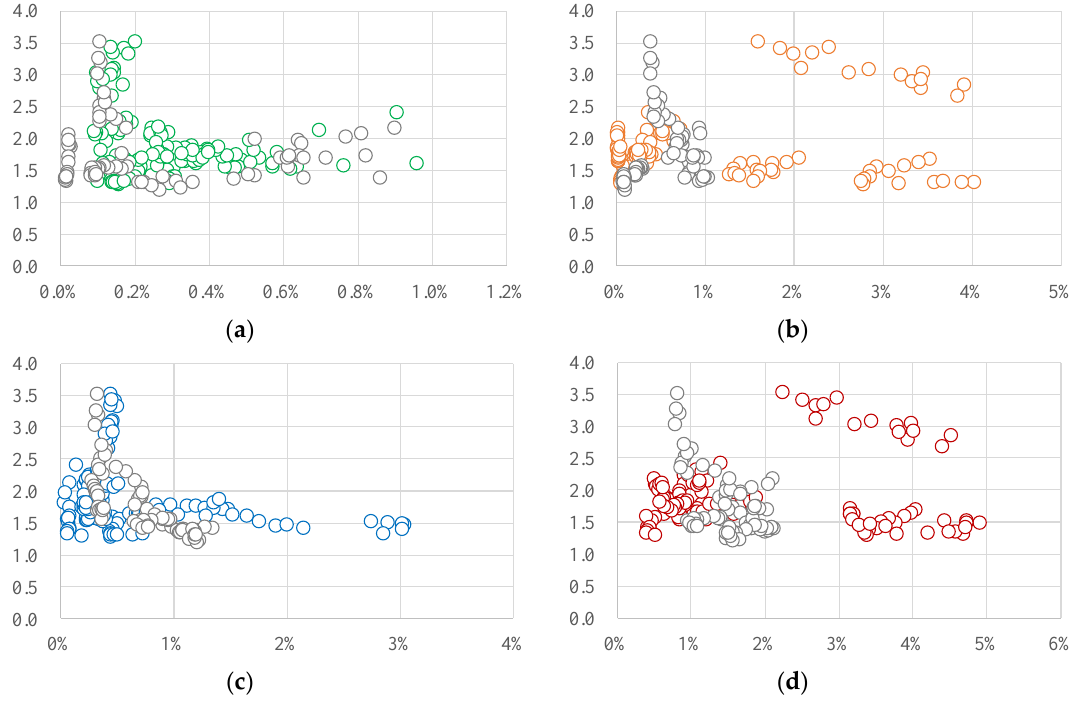
Figure 5. The scatter plot of material productivity (MP) and ICT capital share. ( a ). IT capital share; ( b ). CT capital share; ( c ). Software capital share; ( d ). Share of total ICT capital. Note: The vertical axis shows the MP and the horizontal axis shows the capital share in gross capital stock. Grey color represents countries with a large economic scale.